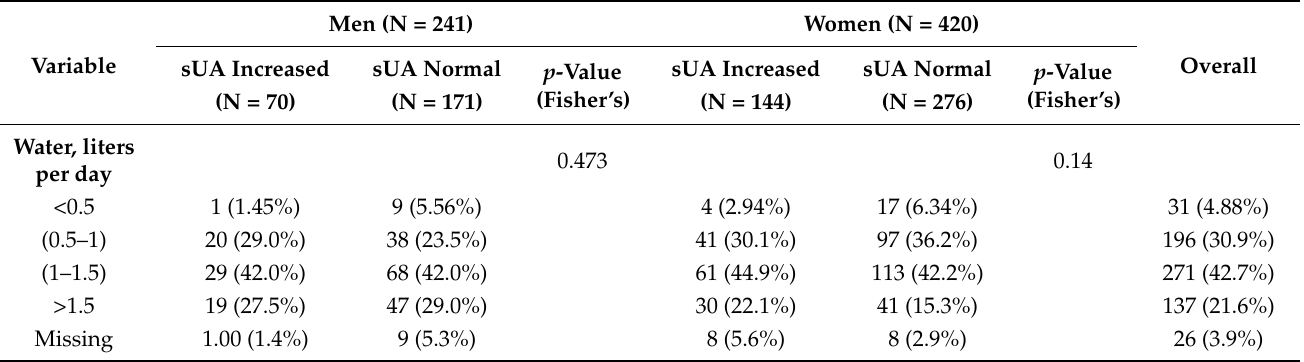
Table 3. Water intake habits of